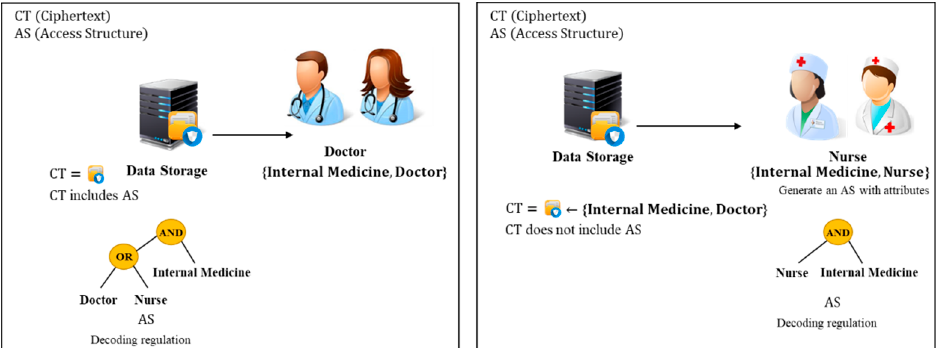
Figure 2. Attribute-Based Encryption (Left ciphertext-policy attribute-based encryption (CP-ABE), Right key-policy attribute-based encryption (KP-ABE)).